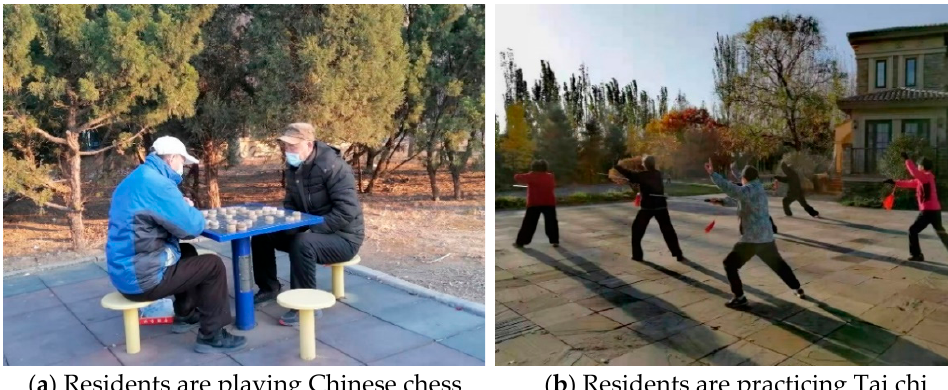
Figure 3. Residents participating in community leisure activities.